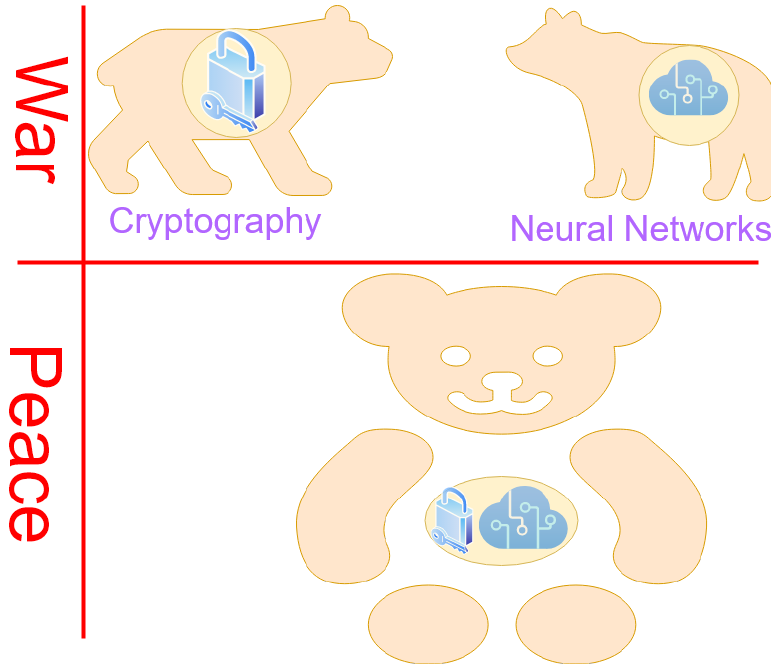
Figure 1. The war-and-peace dichotomy of neural networks and